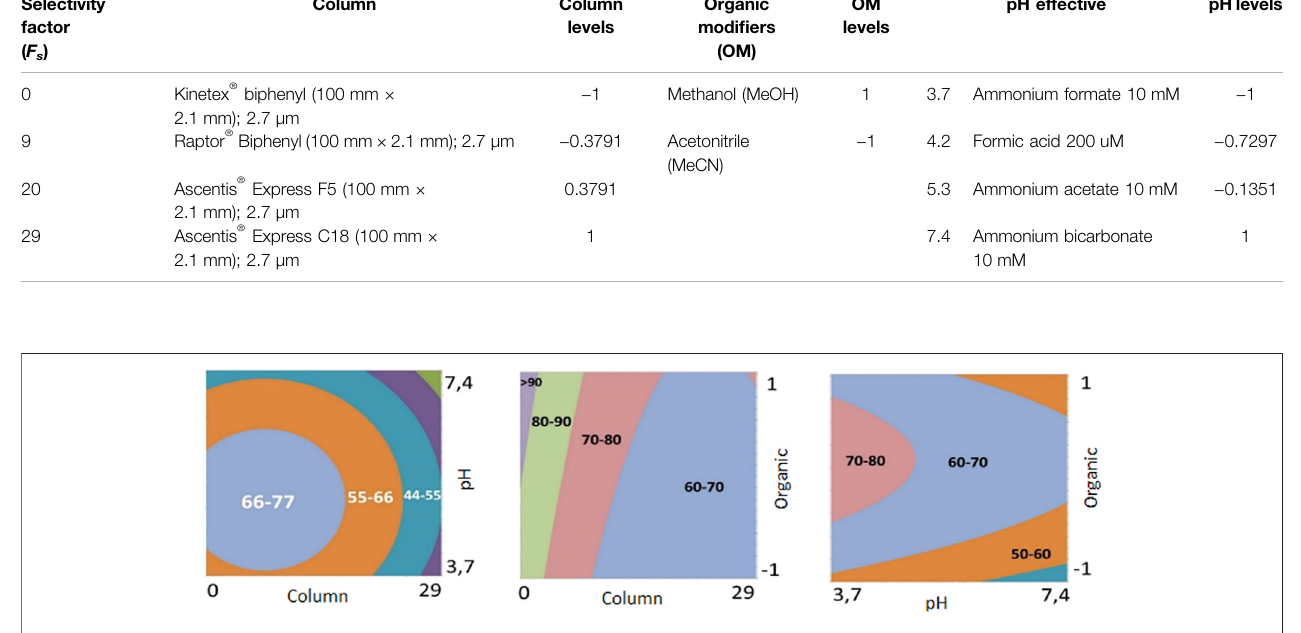
FIGURE 1 | Contour plots obtained in DoE — Step 1 of the experimental design.